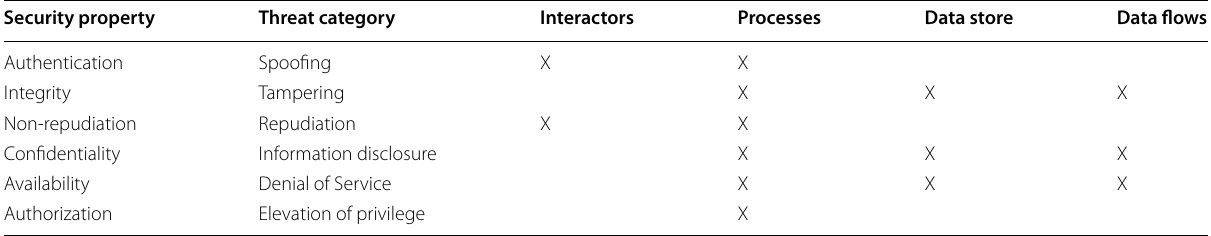
X denotes threat category for a particular component